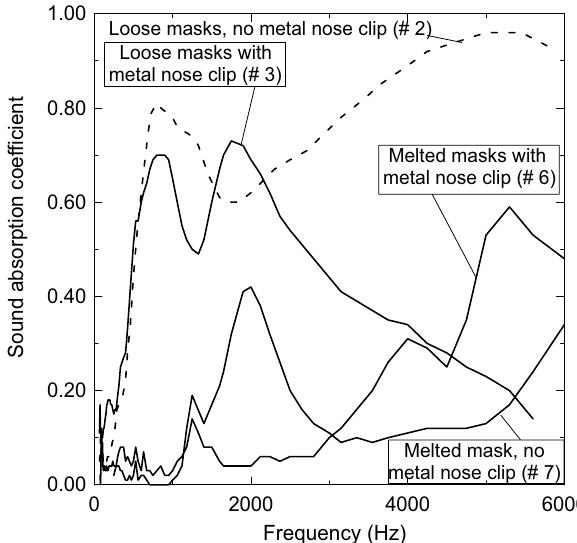
Figure 19. Sound-absorbing coefficients at wide range of frequency for loose and composite (melted) samples.